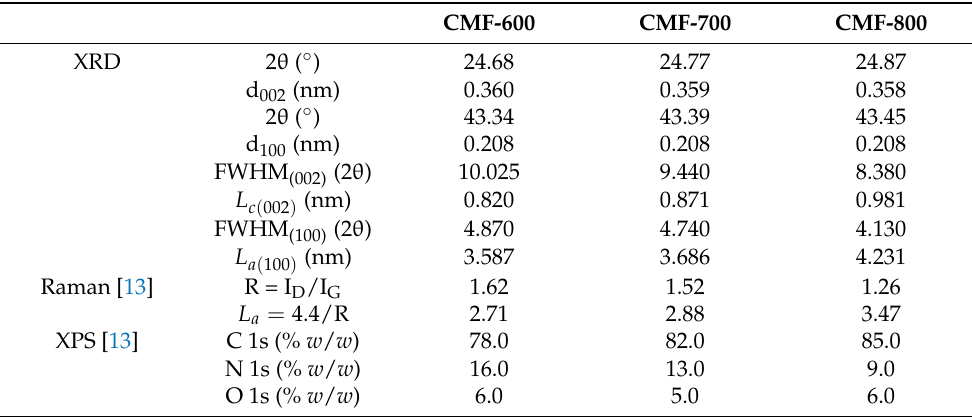
Table 1. Structural and chemical properties of